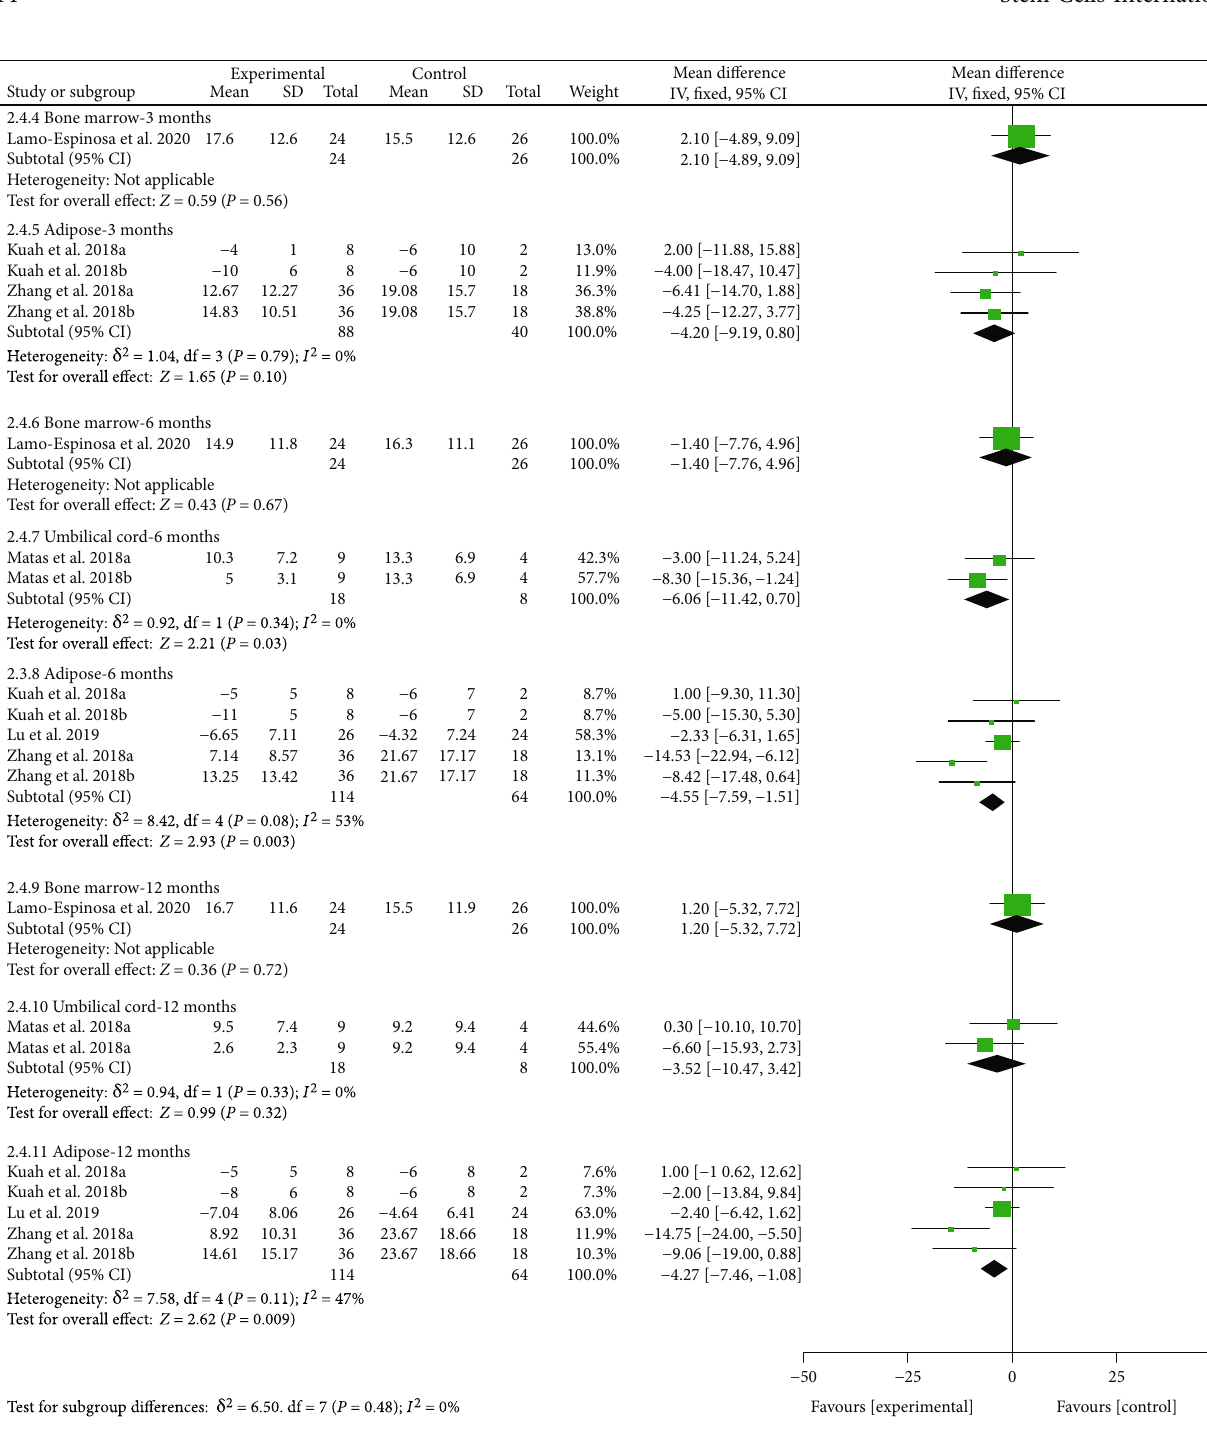
Figure 12: WOMAC physical function-di ff erent cell